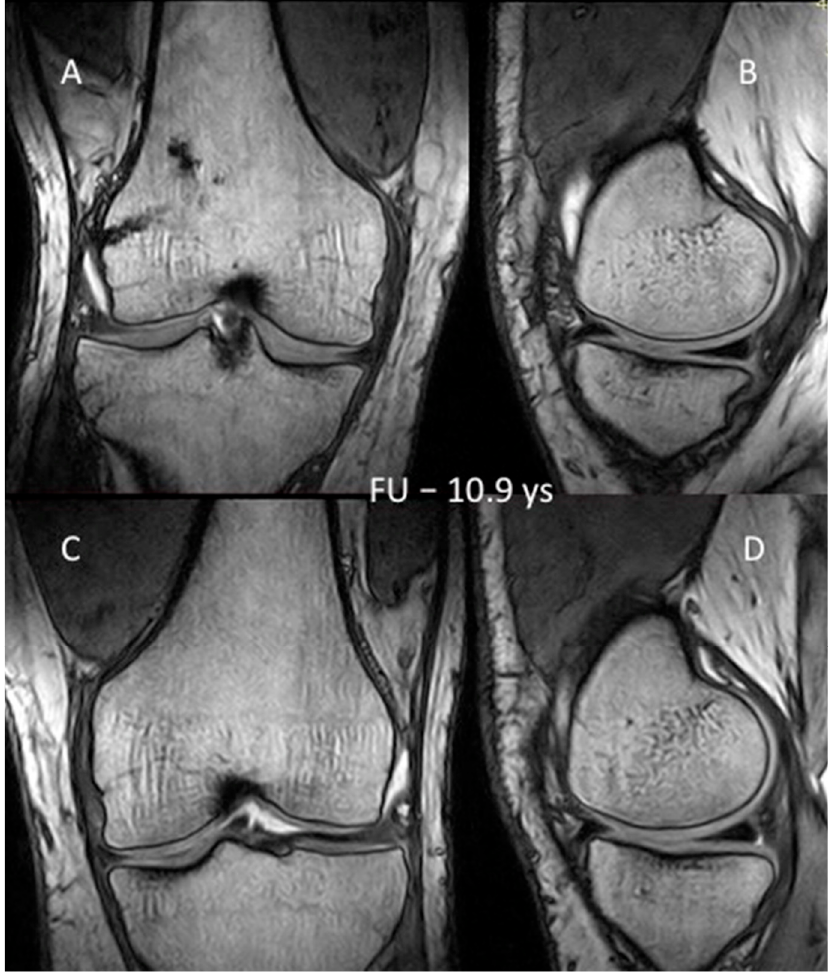
Figure 5. ( A ) MRI scan of the SA knee after ACL-R (frontal plane) obtained during the first follow-up (Patient 3); ( B ) MRI scan of the SA knee after ACL-R (sagittal plane of MFC) obtained during the first follow-up (Patient 3); ( C ) MRI scan of the control knee (frontal plane) obtained during the first follow-up (Patient 3); ( D ) MRI scan of the control knee (sagittal plane of MFC) obtained during the first follow-up (Patient 3). MRI, magnetic resonance imaging; SA, septic arthritis; ACL-R, anterior cruciate ligament reconstruction; MFC, medial femoral condyle. 10.9 years fol- low-up.